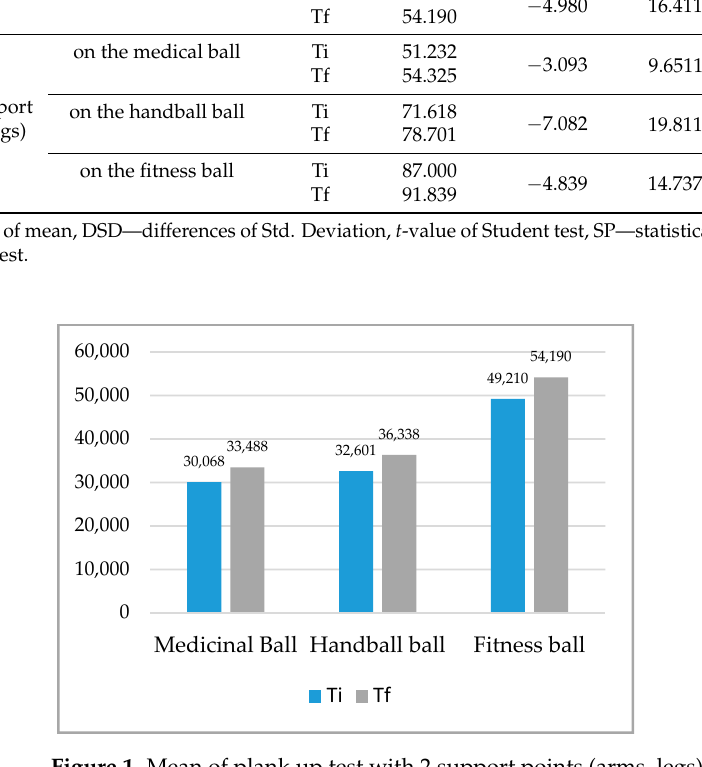
Figure 2. Mean of plank up test with 3 support points (arms, legs). The analysis of the results in Table 3, Figure 3, Figure 4, Figure 5, Figure 6, shows that the superior results were recorded in both tests on the fitness ball, and the inferior results were shown on the medicine ball. In the individual sports group, the highest value was recorded in the final test in the up plank position test with three support points (right arm, left arm, legs) on the fitness ball 93.690, and the lowest in the initial test in the up test plank position with three support points (right arm, left arm, legs) on the fitness ball 28.379. The analysis of the team sports group shows that the highest value was recorded at the final test in the up plank position test with three support points (right arm, left arm, legs) on the fitness ball 90.400, and the lowest at the initial test at the test up plank position with three support points (right arm, left arm, legs) on the fitness ball 31.382. The distribution of the results was normal, according to the S-W results, which ranged between 0.795 and 0.923. All results in both initial and final tests for both groups were statistically significant.